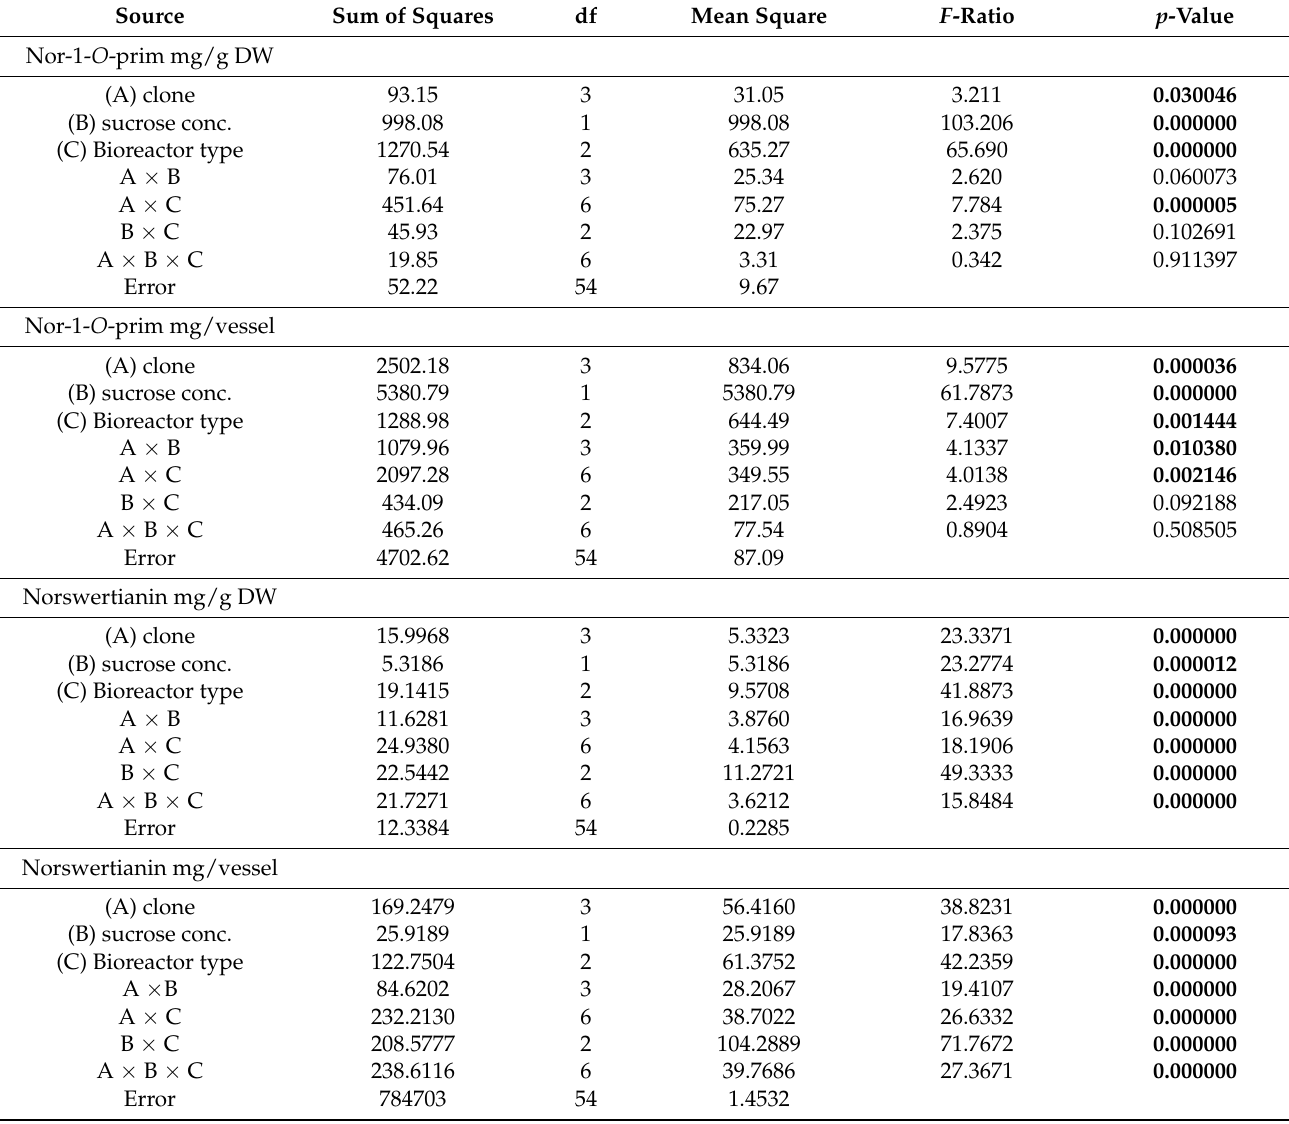
Table 2. Results of nested ANOVA for the effects of clone (A), sucrose concentration (B), and bioreactor type (C) on the content of norswertianin-1- O -primeveroside and norswertianin in hairy root cultures of Gentiana dinarica. The bold values indicate statistically significant results ( p ≤